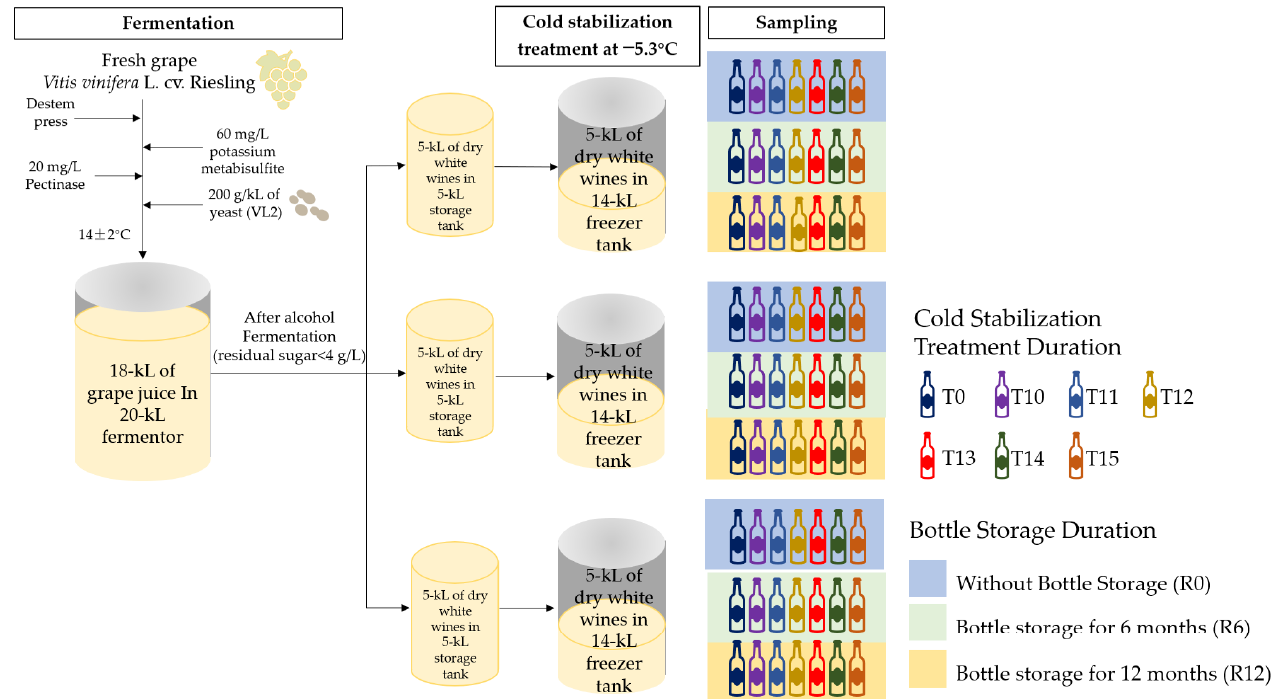
Figure 1. Schematic diagram of winemaking and